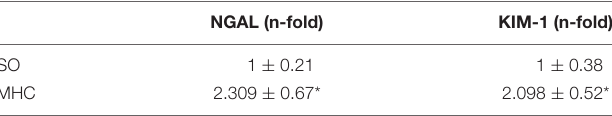
TABLE 2 | NGAL and KIM-1 levels in kidneys from Sham-Operated (SO) and microsurgical liver cholestasis (MHC) rats. NGAL (n-fold) KIM-1 (n-fold) SO